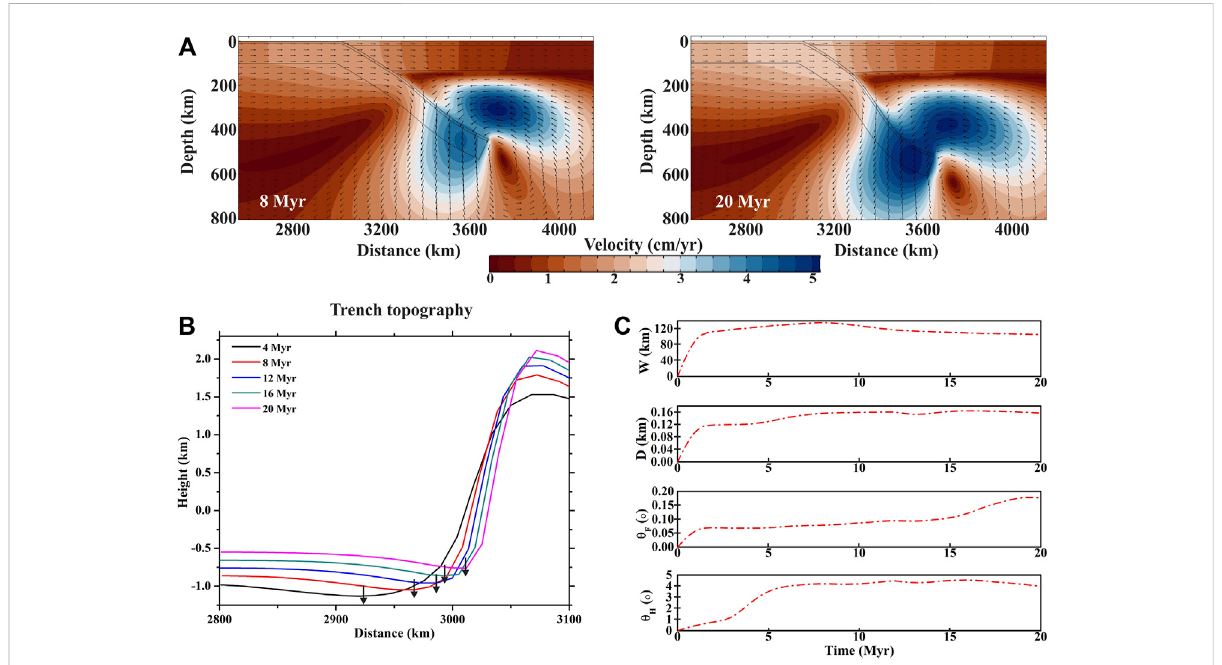
FIGURE 3 (A) Velocity fi eldsproducedinthereferenceexperimentcorrespondingtomodelruntimes:8and20Myr.Notethatthesubductingslabcreates a fl ow vortex in the mantle, which intensi fi es with time. (B) A time series plots of absolute topographic elevations of a trench topography in the reference model. (C) Temporal variations of the trench parameters: W (opening width), D (maximum negative relative relief), θ H (HW slope), and θ F (FW slope) presented from the reference experiment.